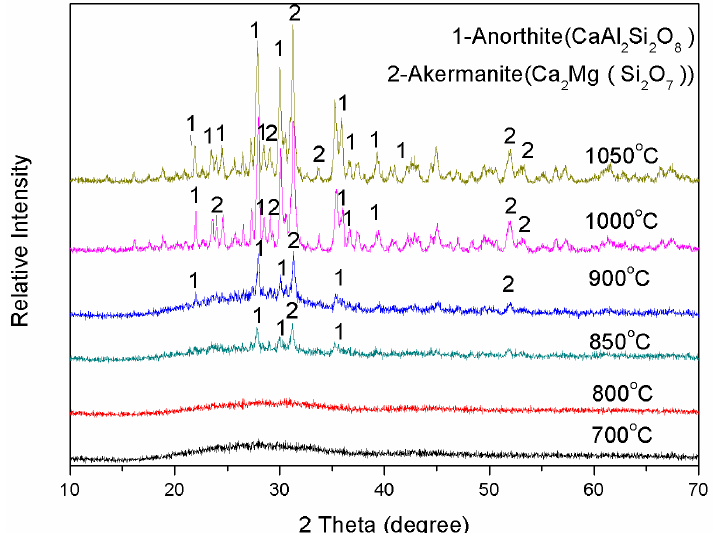
Figure 10. XRD patterns of slag fiber after being annealed at different temperatures for 4